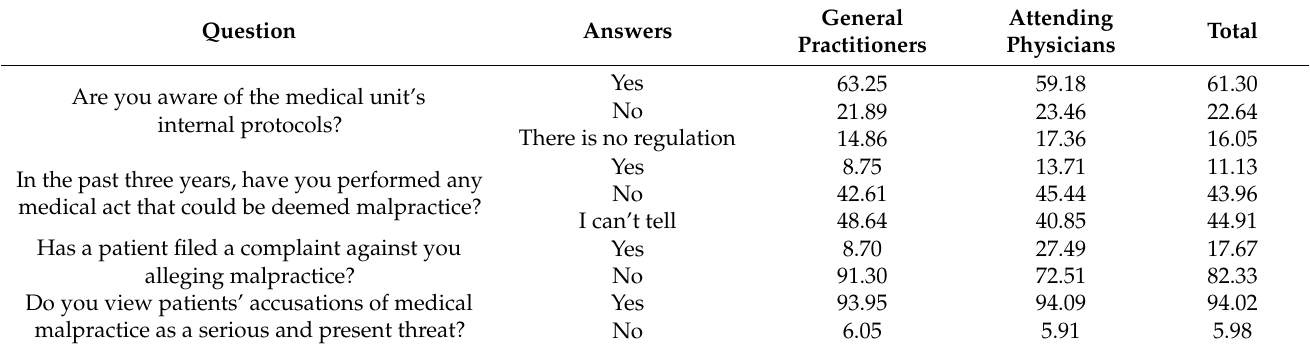
Table 3. Physicians’ legal compliance at a national level